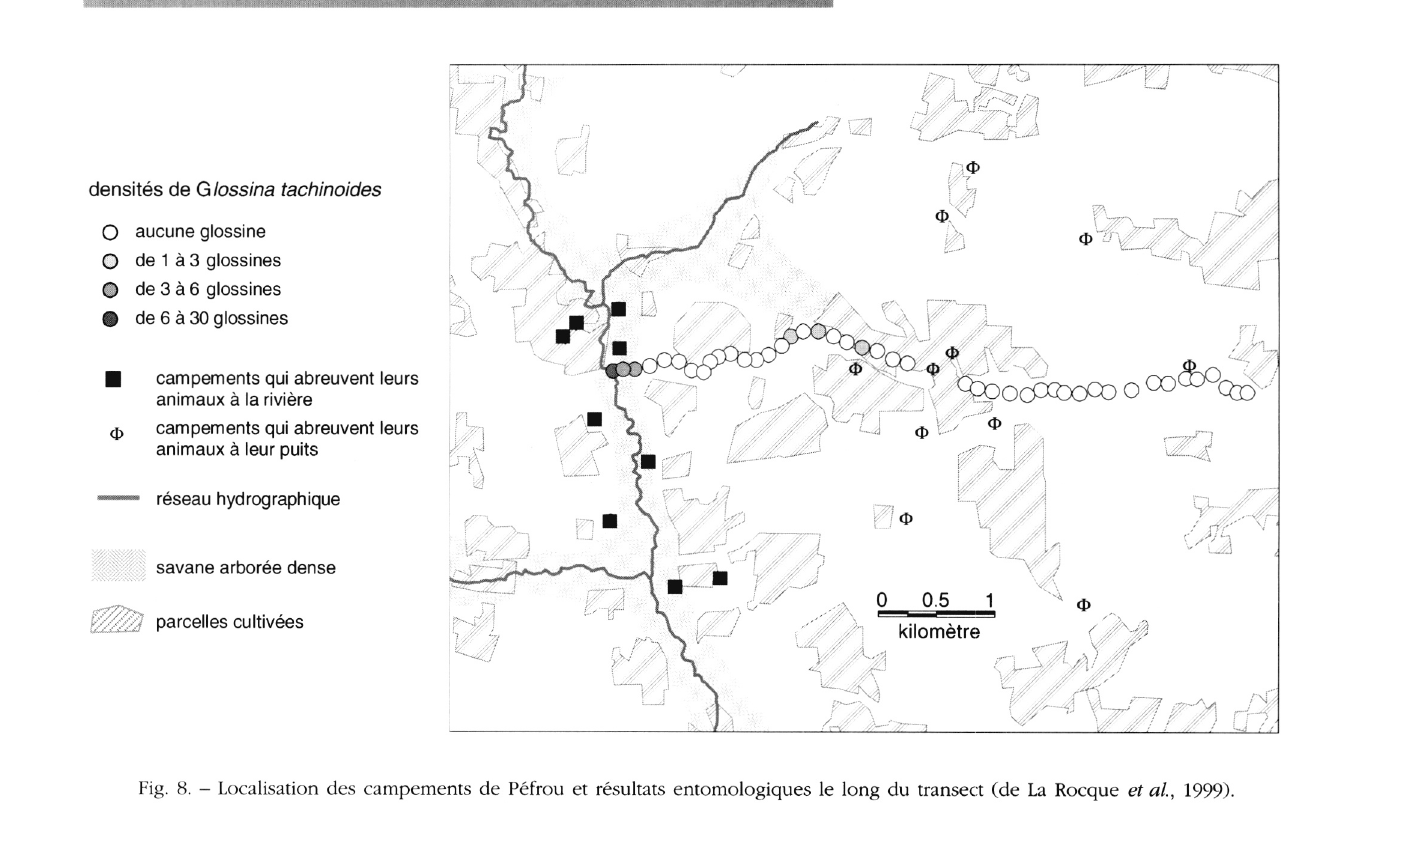
Fig. 8. - Localisation des campements de Péfrou et résultats entomologiques le long du transect (de La Rocque et al , 1999).